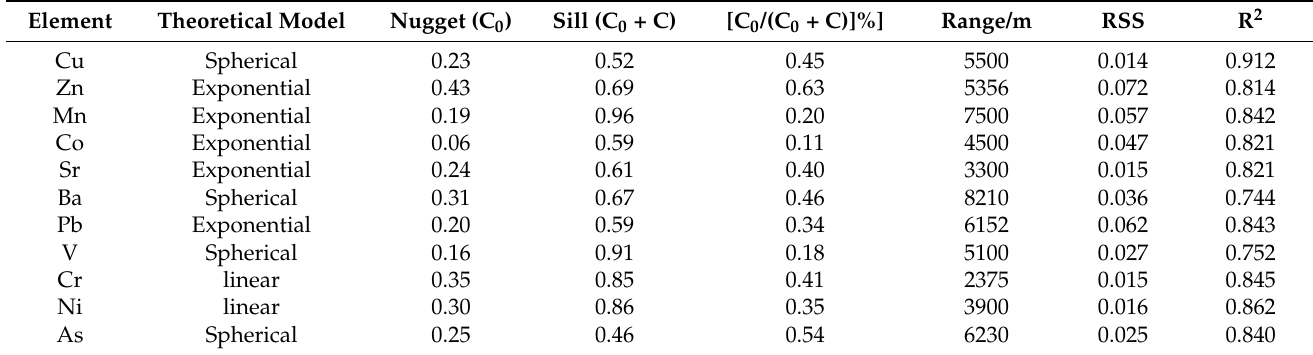
Table 3. The results of the semivariance function analysis of heavy metal elements in the